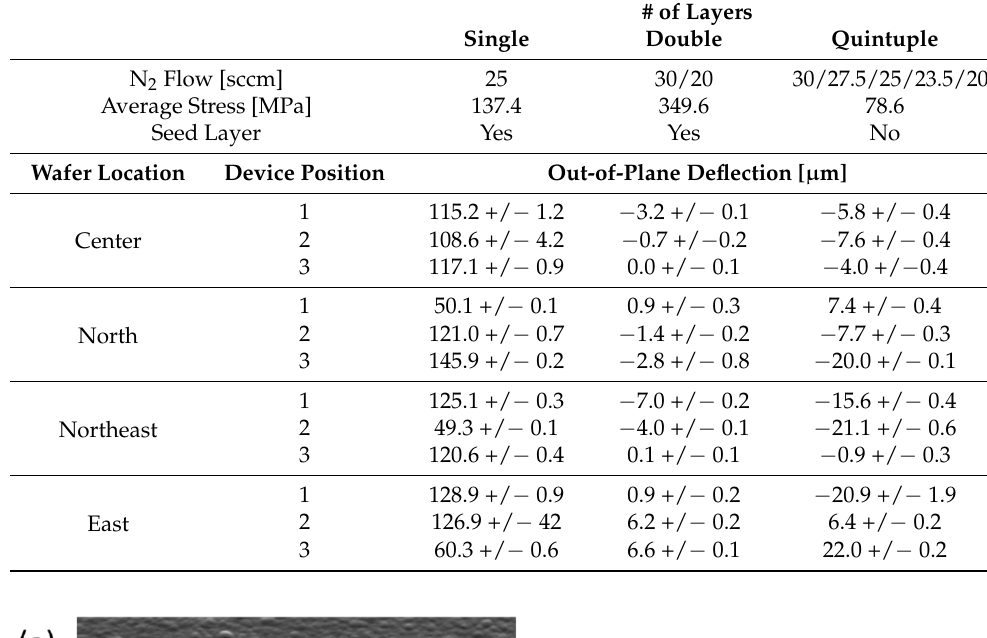
Table 2. Cantilever tip deflection for 500 nm Al 0.68 Sc 0.32 N with and without stress gradient compensation.